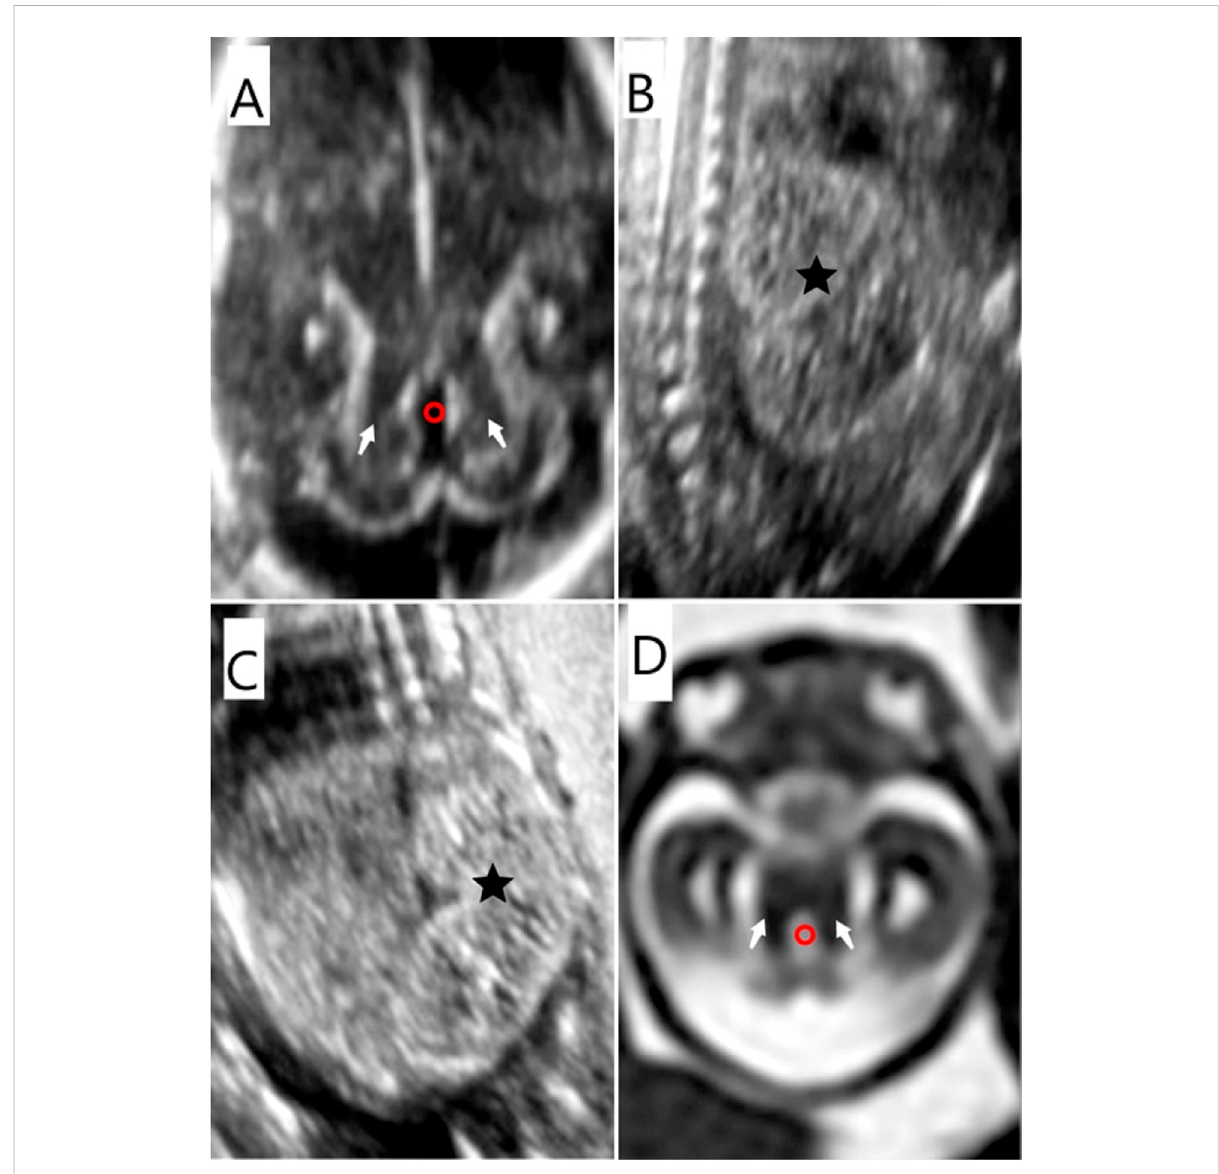
FIGURE 2 Prenatal imaging features of the fetus in case 7. (A) (D) MTS (white arrow) was detected by US and MRI. The fourth ventricle presented as “ elongated ” (red circle) on US and MRI. (B) (C) Bilateral polycystic kidneys ( + ) were identi fi ed by